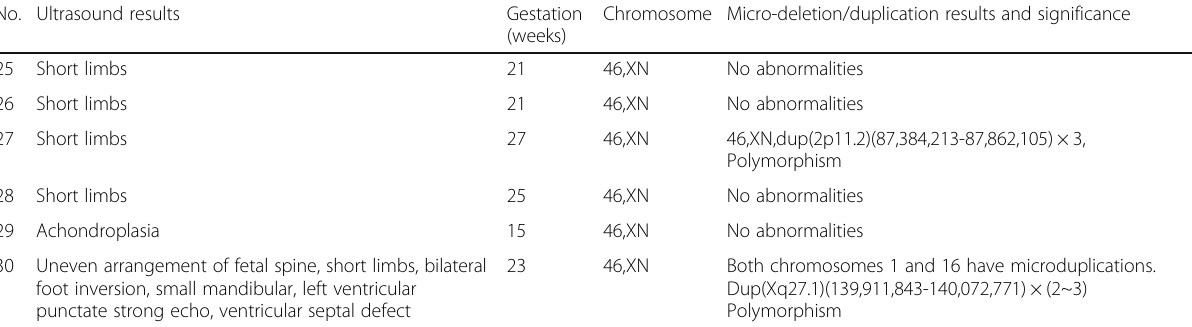
Table 1 General data for 30 cases of fetal skeletal dysplasia, including chromosome information and microdeletion/microduplication test results